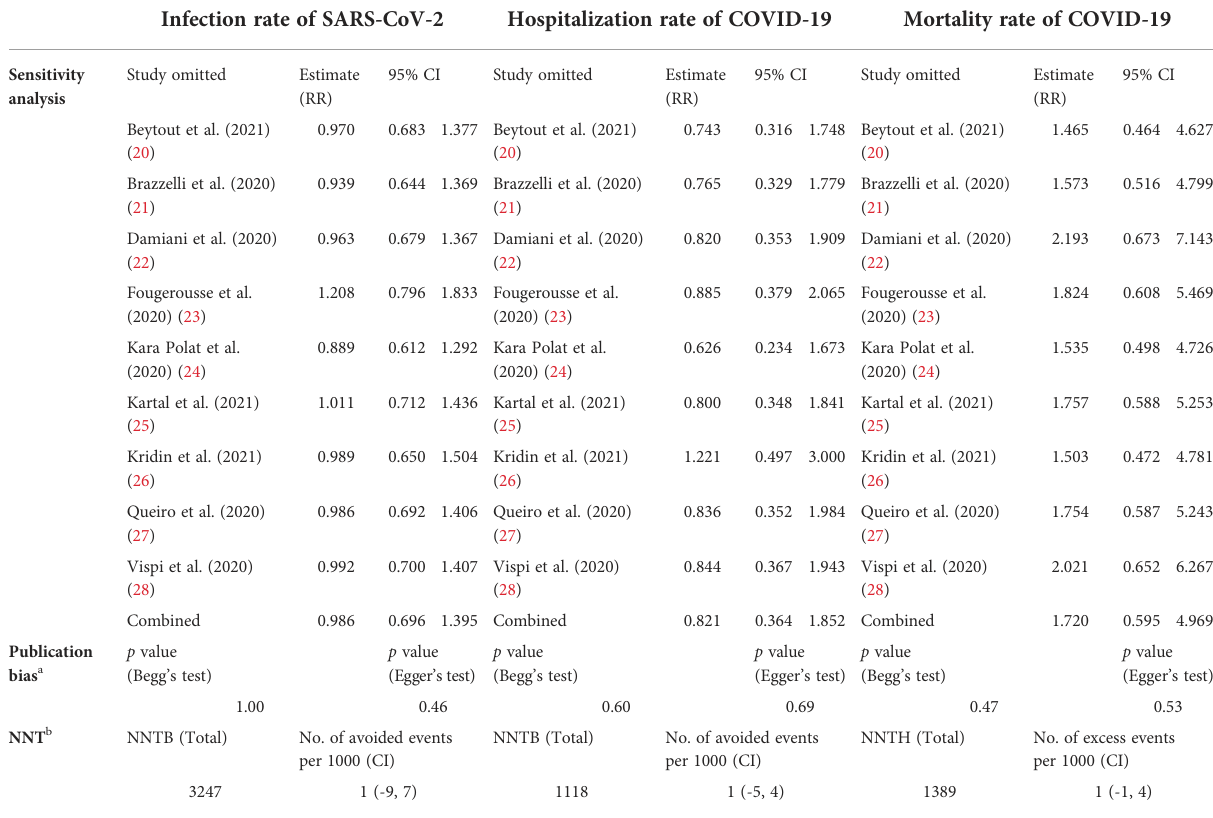
TABLE 2 Summary of Analysis